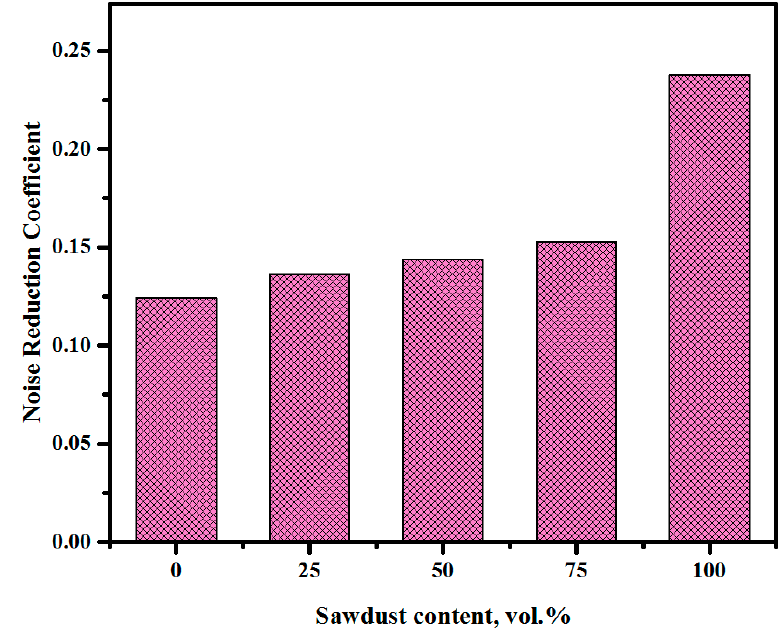
Figure 18. E ff ects of the sawdust contents on the noise reduction coe ffi cient of the proposed alkali-activated